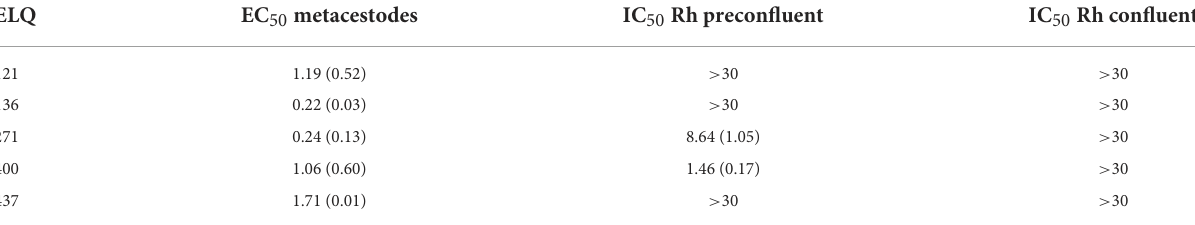
The first number indicates the ELQ numbers. Efficacy against metacestodes (isolate H95) was assessed by PGI assay (relative to the positive control Tx-100) and EC 50 values are given in µ M (concentration range tested: 30–0.12 µ M). Activity against mammalian cells (Reuber rat hepatoma cells, Rh) was assessed by Alamar blue assay (relative to the DMSO control), and